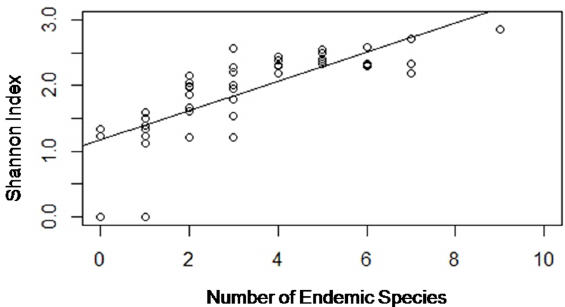
Figure 7. Number of species and individuals across GBH classes.